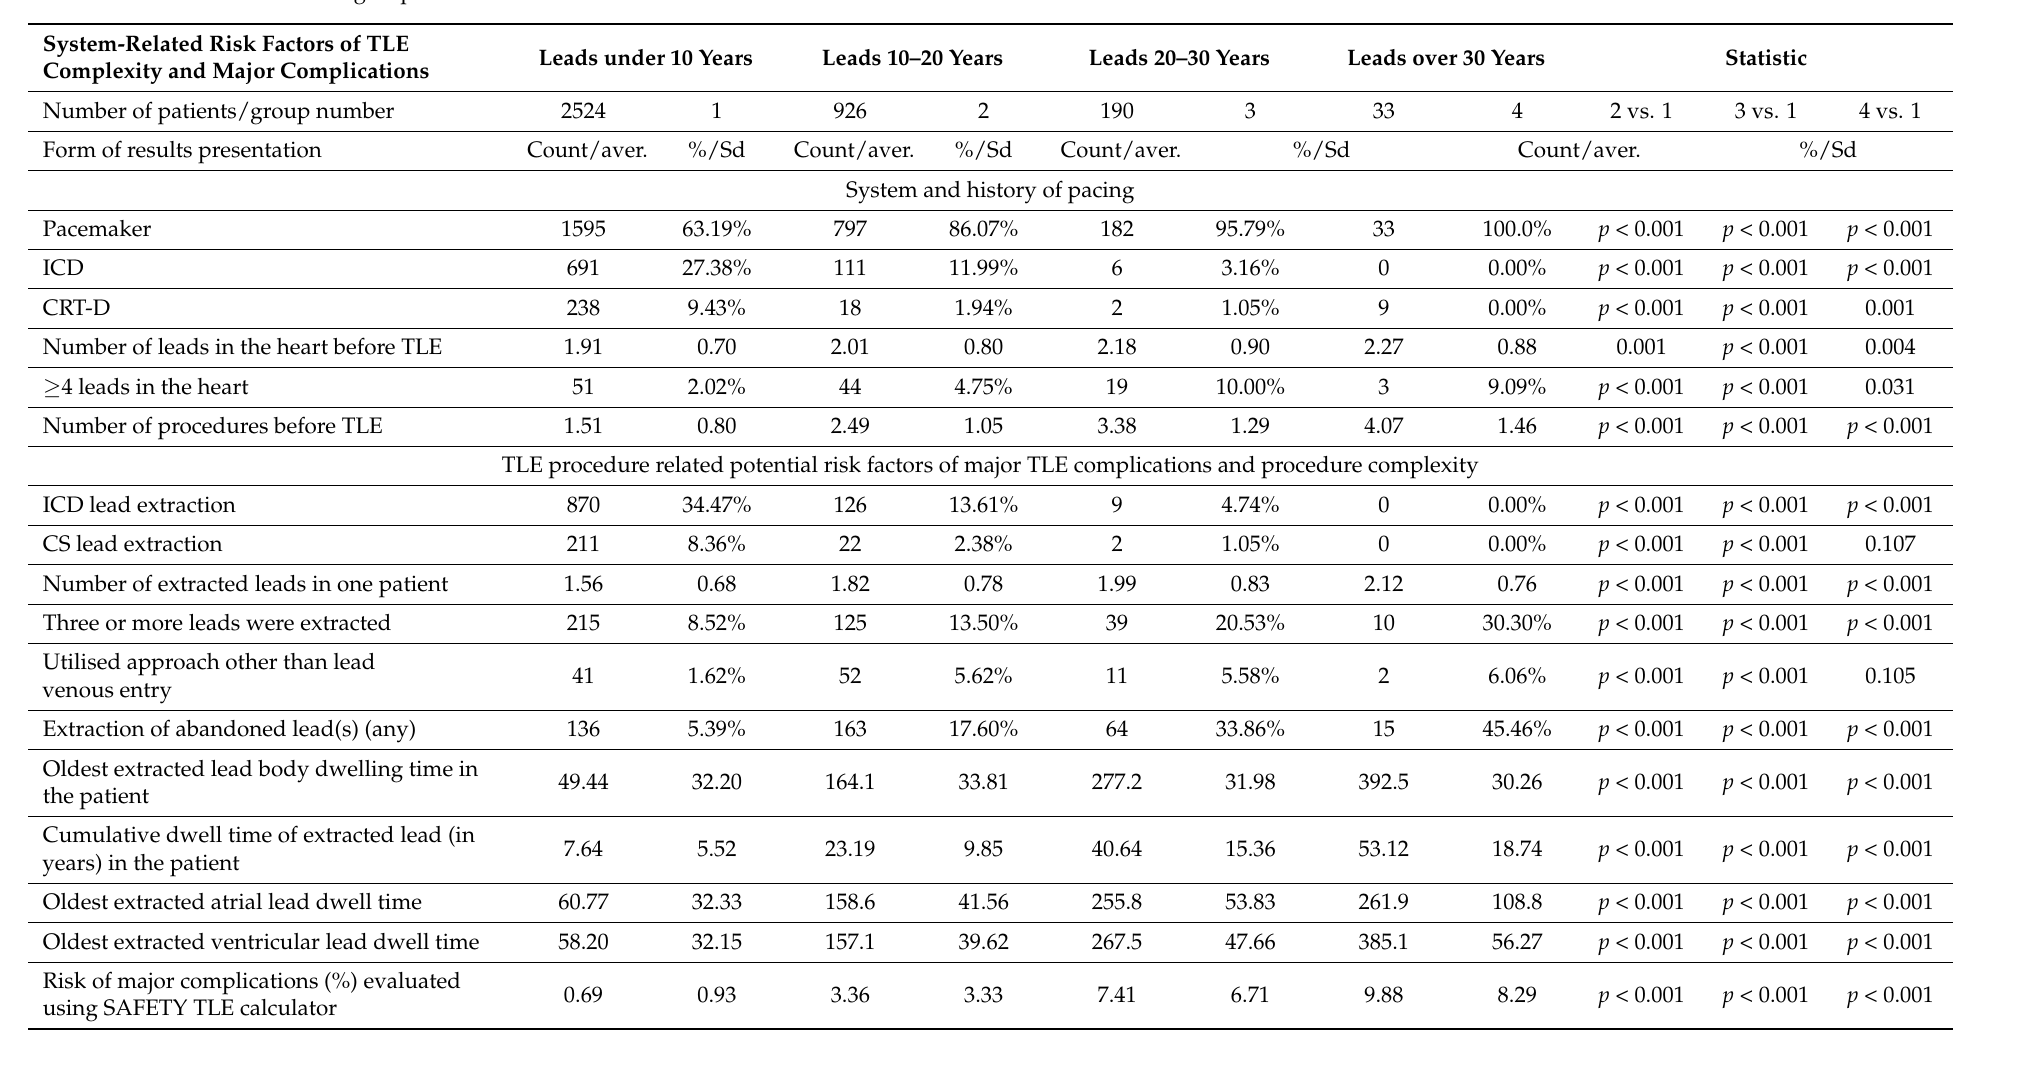
Table 3. System related, pacing related and procedure related risk factors of major TLE complications and procedure complexity in different implant duration